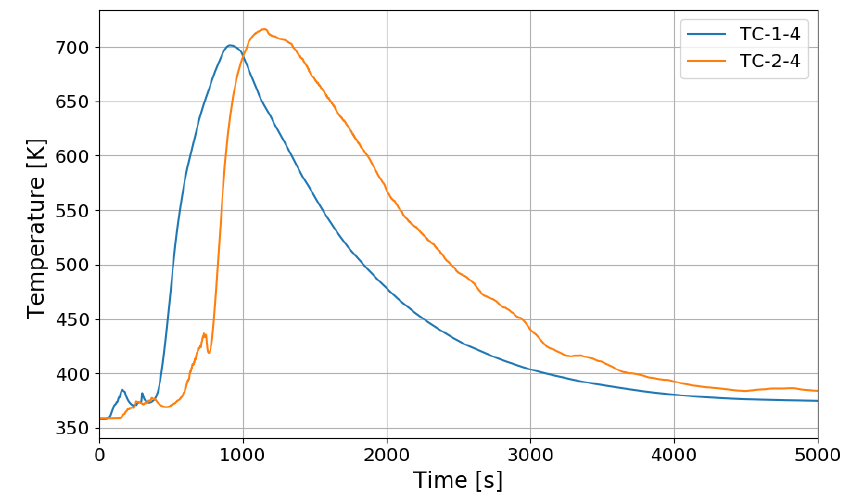
Figure 24. Temperature behaviors on catalytic plates of the PARs for the SP5 test.